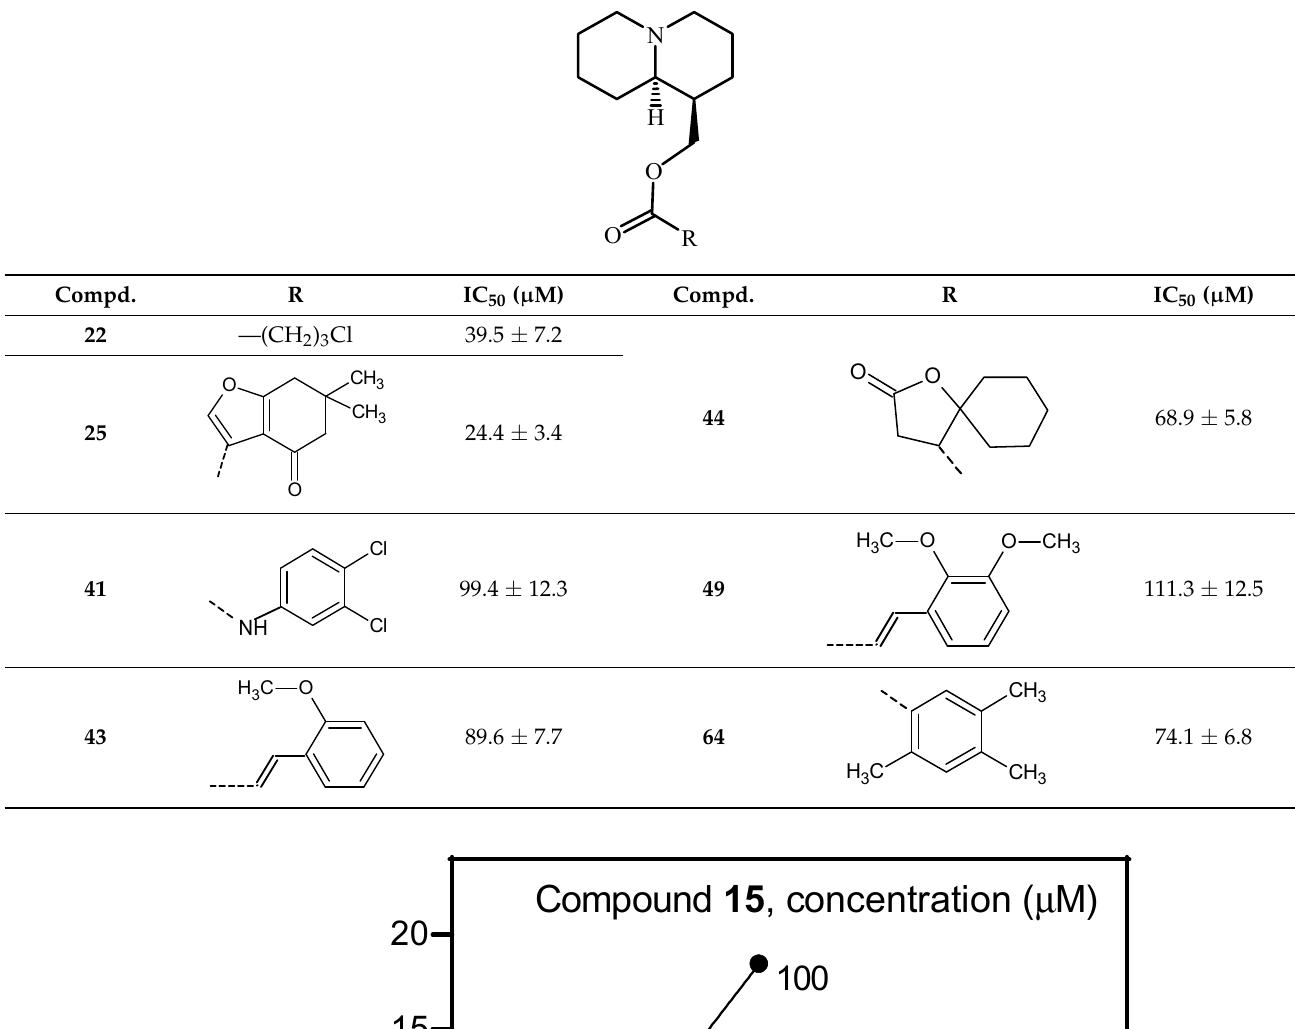
Table 2. AChE inhibitory activity of lupinine-based esters of different carboxylic acids.